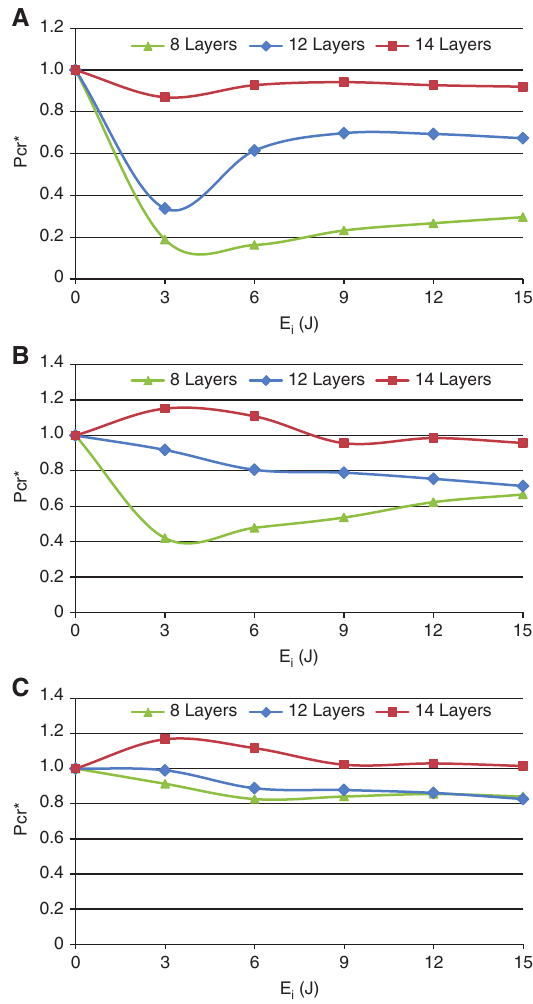
Figure 9 Distributions of the buckling loads versus impact energy at (A) center, (B) 15 mm, and (C) 30